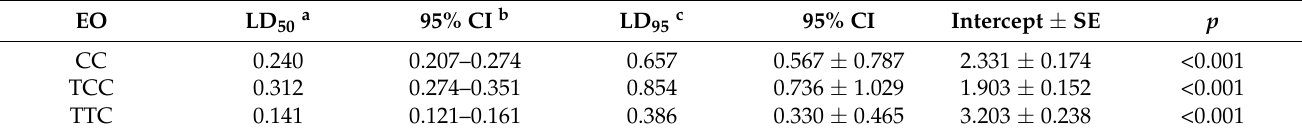
a , Dose of EO that kills 50% of the insects; b , confidence interval; c , dose of EO that kills 95% of the insects. Data are calculated by Probit regression analysis and given as µ L insect − 1 . CC, carvacrol chemotype; TCC, thymol/ p -cymene chemotype; TTC thymol/ γ -terpinene chemotype. Model slope = 3.76 ± 0.30; Pearson goodness-of-fit test, χ 2 = 10.717, df = 7, p = 0.151; Parallelism test, df = 2, p =